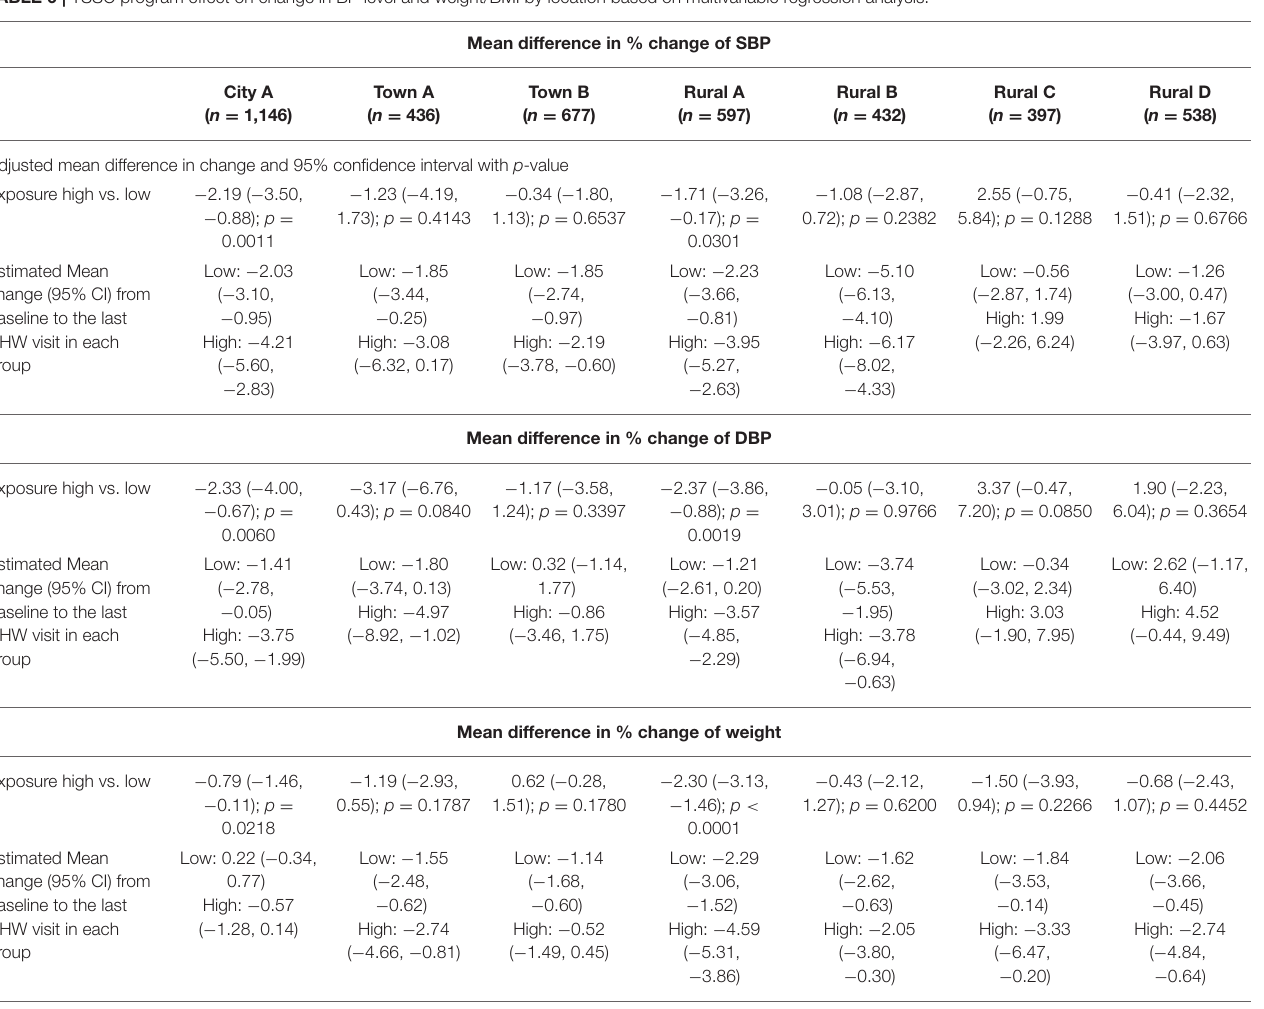
TABLE 6 | TSSC program effect on change in BP level and weight/BMI by location based on multivariable regression analysis. Adjusted mean difference in change and 95% confidence interval with p -value Exposure high vs.